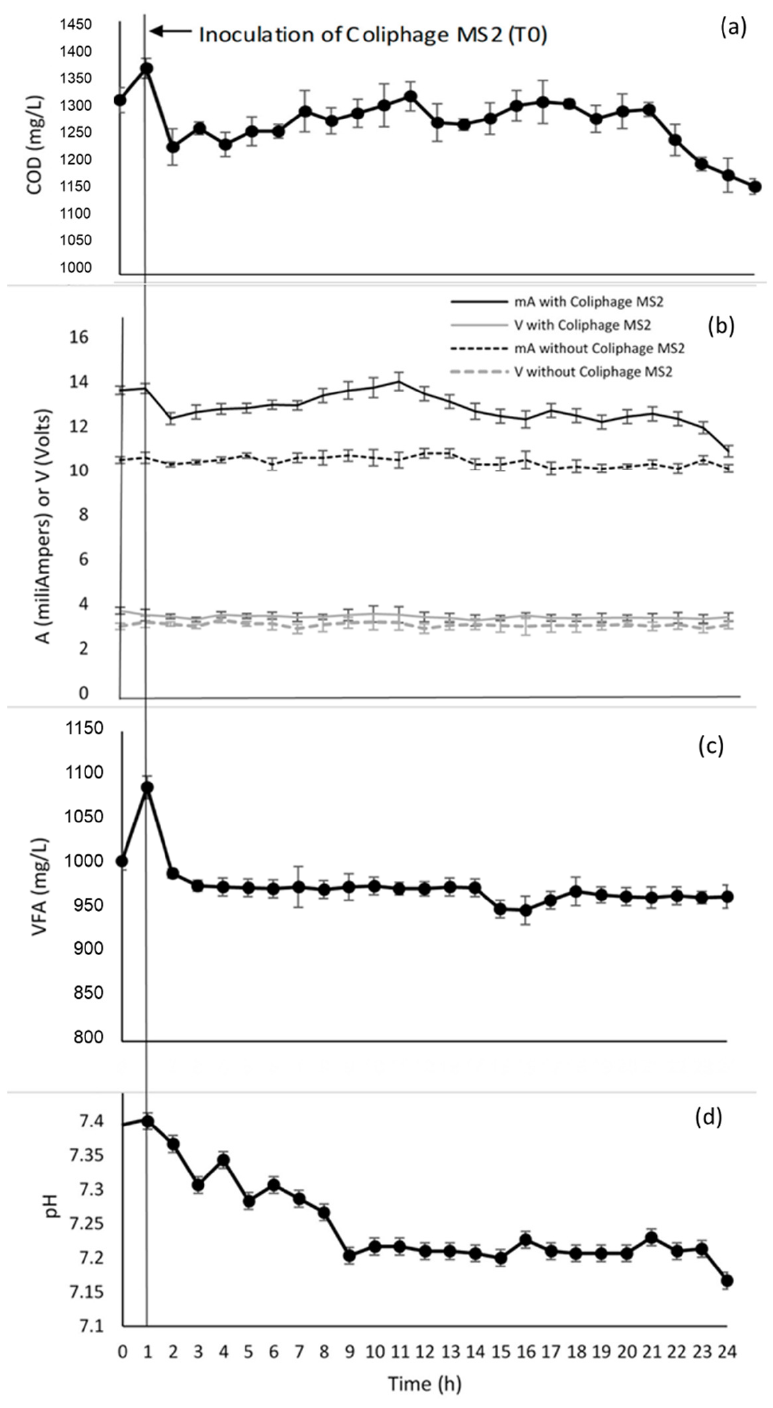
Figure 2. Evaluation of physicochemical and electrochemical parameters during wastewater treatment and reduction of coliphage MS2: ( a ) COD mg/L; ( b ) current and voltage; ( c ) VFA mg/L; ( d ) pH.